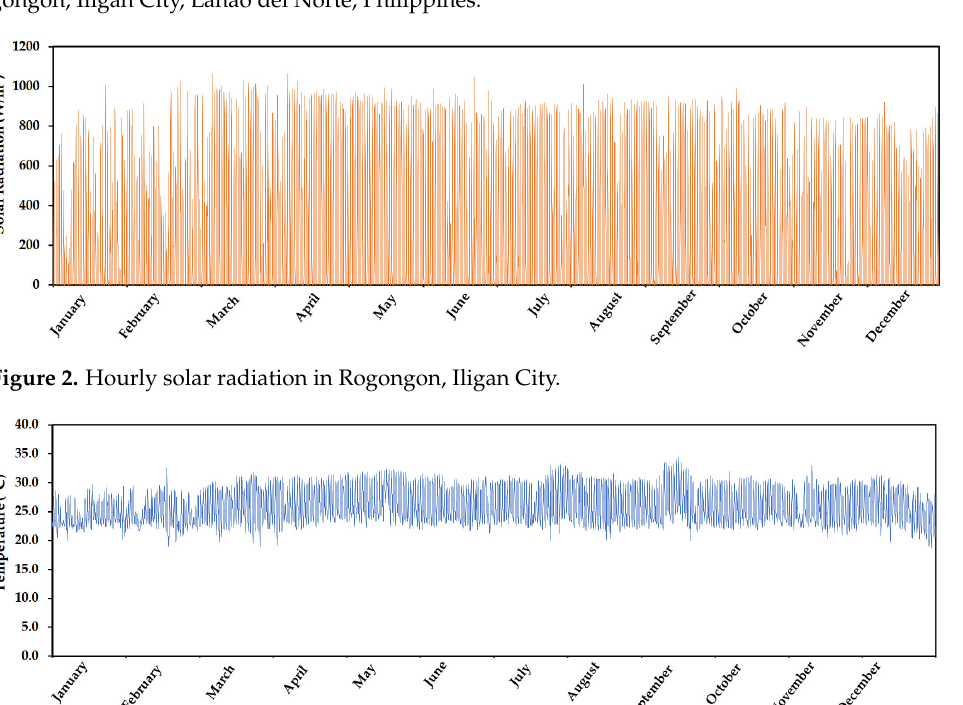
Figure 1. Study area—rural agricultural area composed of five unelectrified sitios , or sites, in Ro- gongon, Iligan City, Lanao del Norte, Philippines.